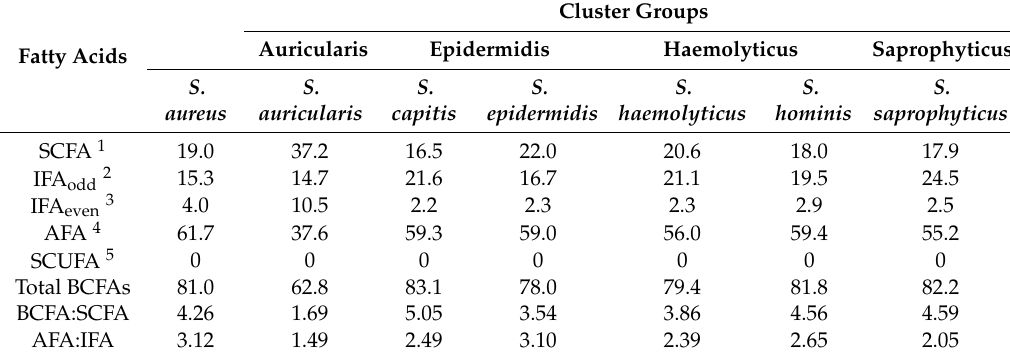
Fatty acid composition (%) of Mueller–Hinton broth-grown coagulase-negative staphylococcal